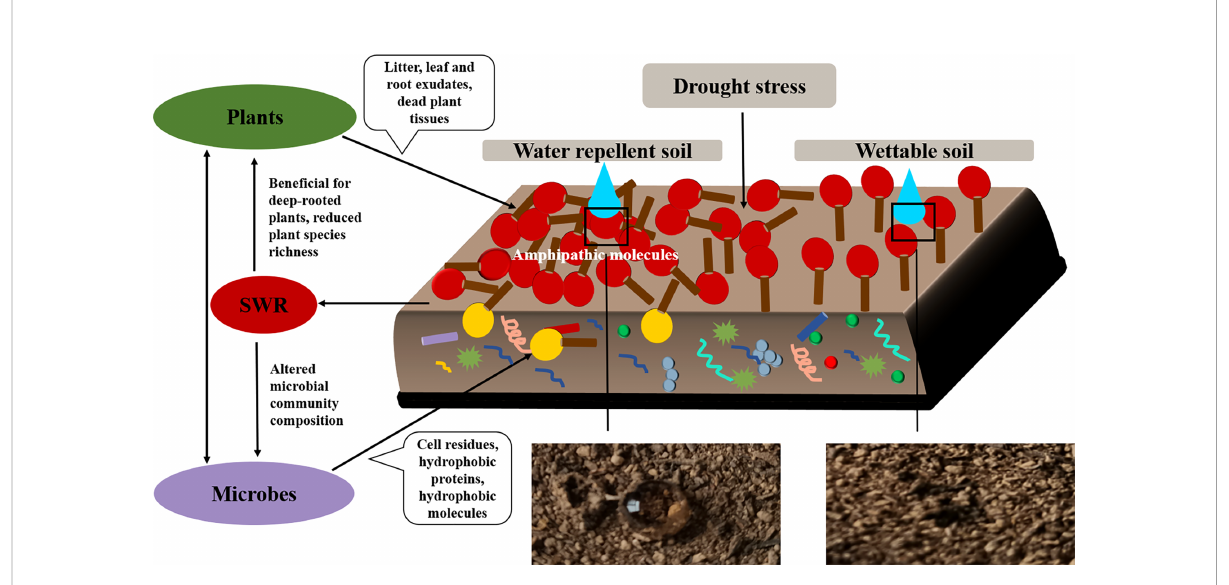
FIGURE 12 The correlation between plants, microorganisms, and